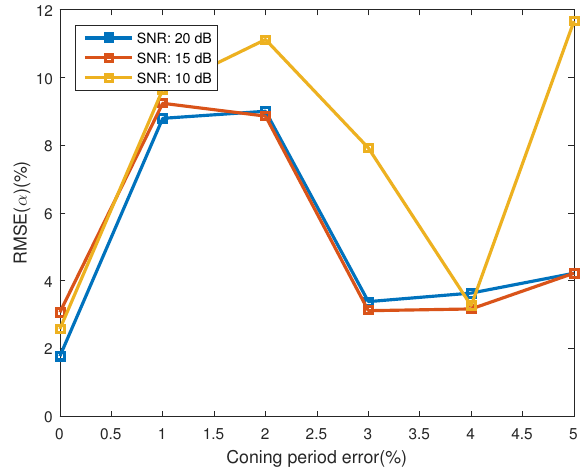
Figure 10. The estimating error of coning